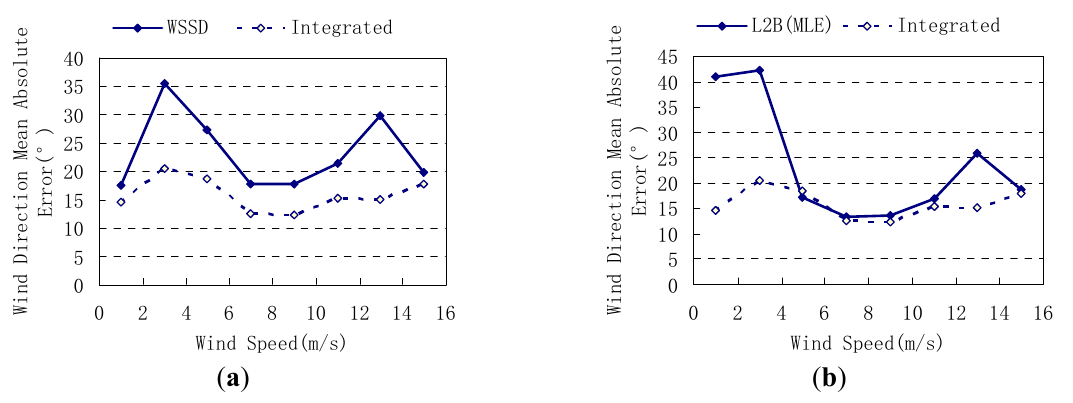
Figure 4. The wind direction mean absolute error at each wind speed interval in the nadir region: ( a ) comparisons between the traditional WSSD and the integrated algorithm and ( b ) comparisons between the integrated algorithm and the L2B (MLE)